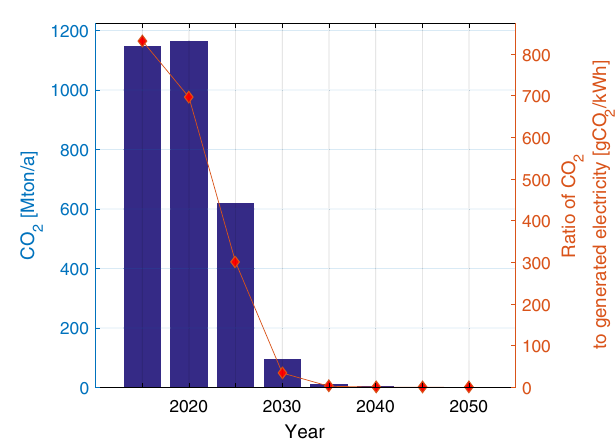
fossil fuel based system.